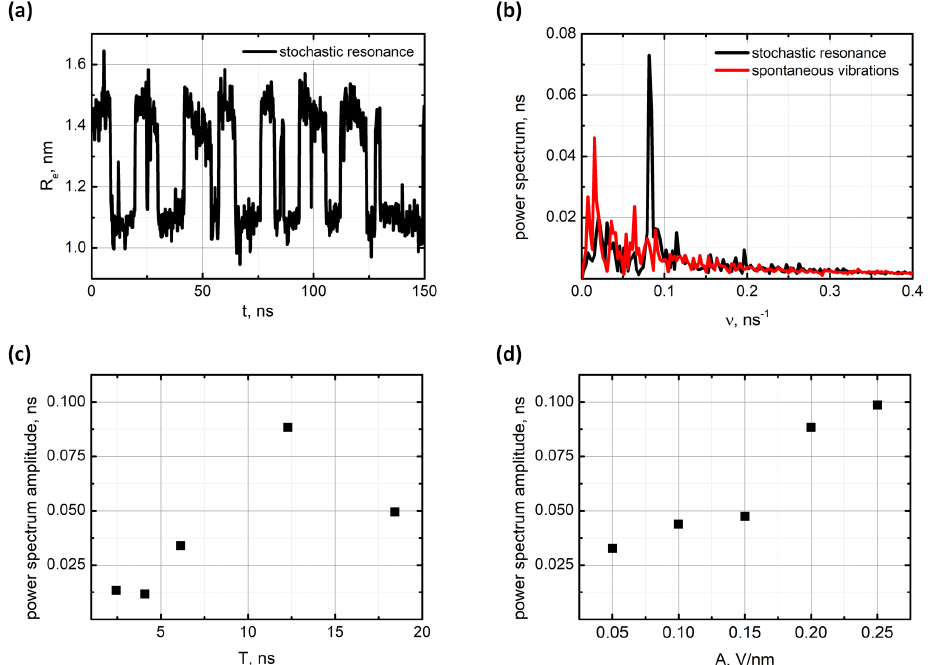
Figure 3. Stochastic resonance of the oligo-PF-5 induces by an oscillating field E = E 0 cos ( 2 πν t ) = E 0 cos ( 2 π t / T ) : ( a ) The dynamic trajectory at F = 279pN, T = 12.28ns, and E = 0.2Vnm − 1 ; ( b ) Power spectrum of spontaneous vibrations (red curve) and stochastic resonance (black curve); ( c ) The depen- dence of the main resonance peak amplitude on the period T of oscillating field ( E 0 = 0.2Vnm − 1 ); ( d ) The dependence of the main resonance peak amplitude on E 0 ( T =